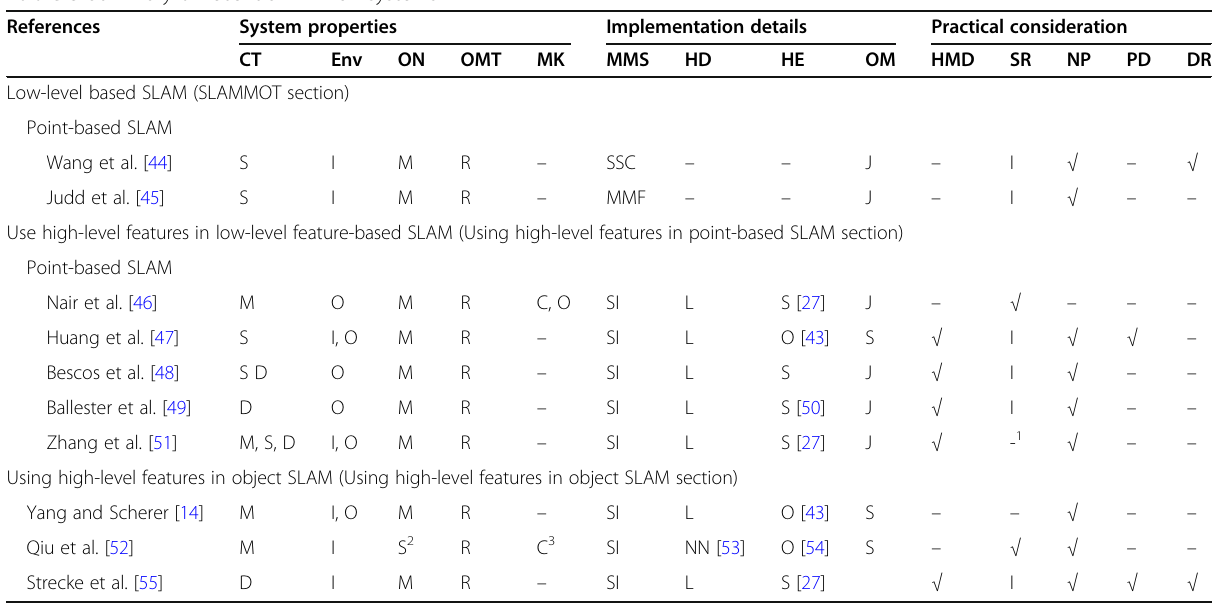
Table 3 Summary of recent SLAMMOT